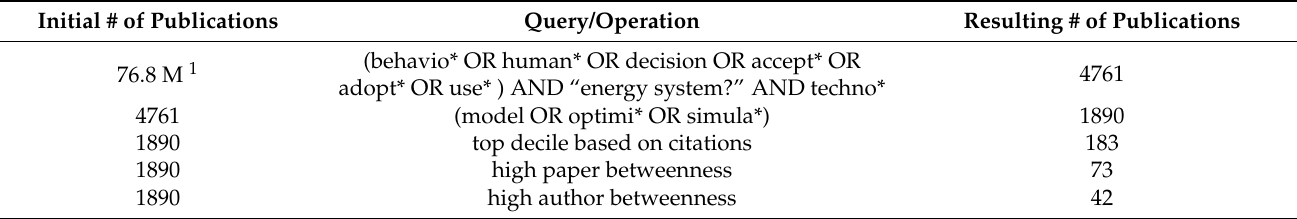
Table 1. Search query and further operations performed on the corpus. The operators “?” and “*” allow for word completion with one or any numer of characters